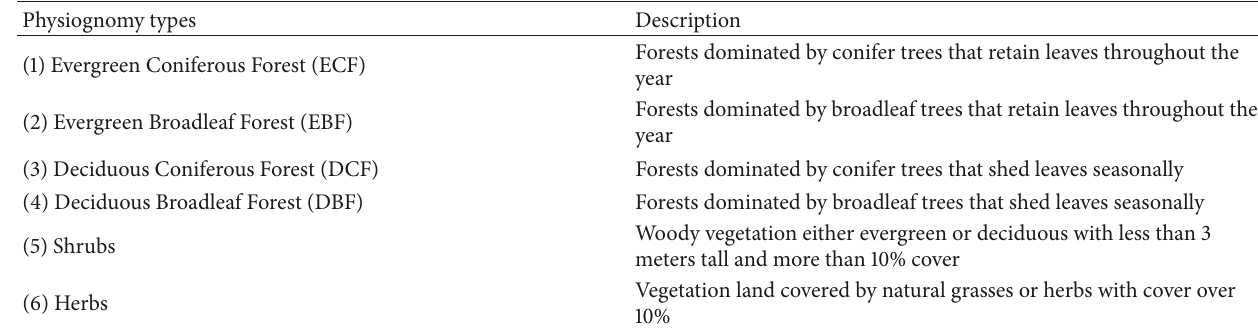
Table 1: Vegetation physiognomy types used in the research.